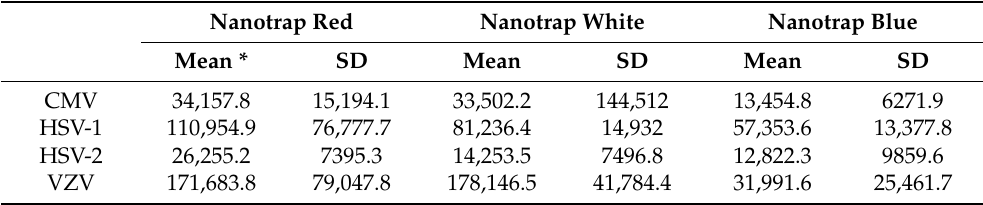
Table 1. Mean and standard deviation values (in cp/mL) for each of the custom Nanotrap particle types tested: Nanotrap Red, Nanotrap White, and Nanotrap